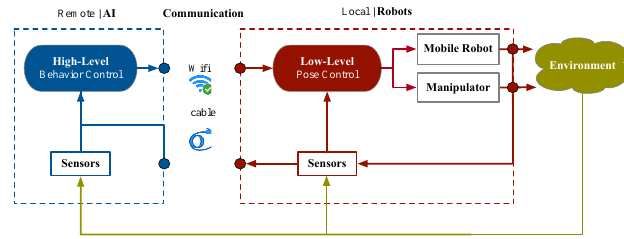
Figure 4. Hierarchical control: High level and low level.